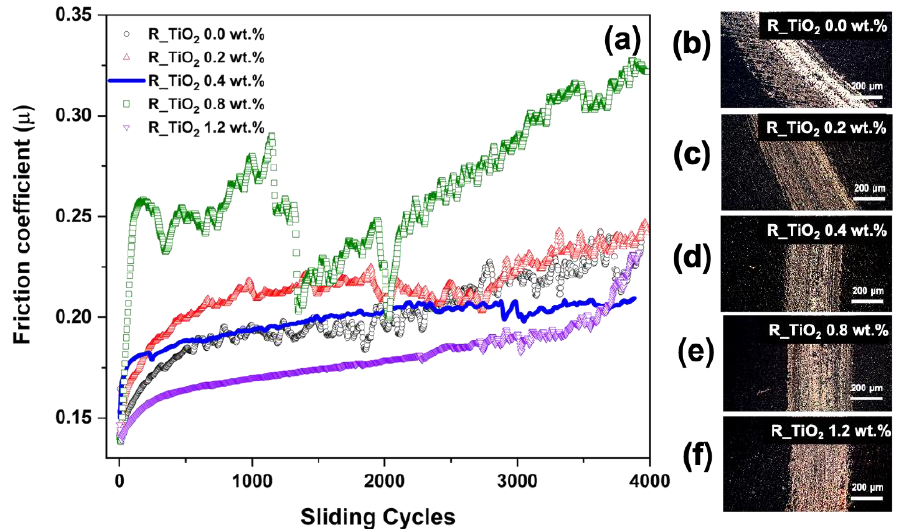
Figure 5. 3D printed polymer nanocomposites (R_TiO 2 X wt.%) and control sample (pure resin) ( a ) friction coefficient ( µ ) evolution, and ( b – f ) images of the wear tracks.